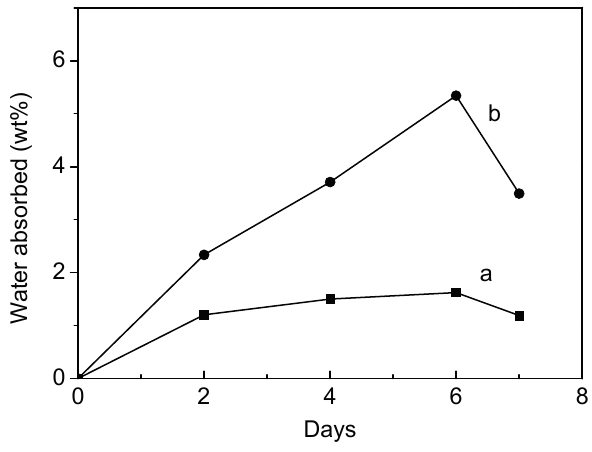
Figure 5. Water absorption behavior of (a) PLA and (b) collagen-PLA.